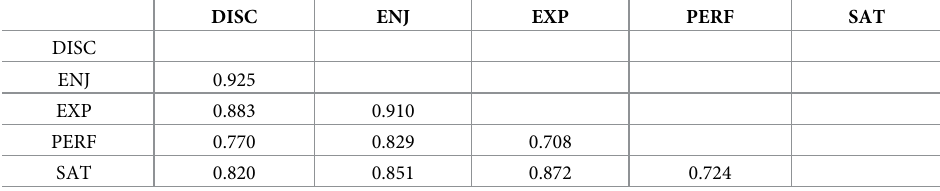
Table 4. Heterotrait-monotrait ratio (HTMT) for discriminant validity